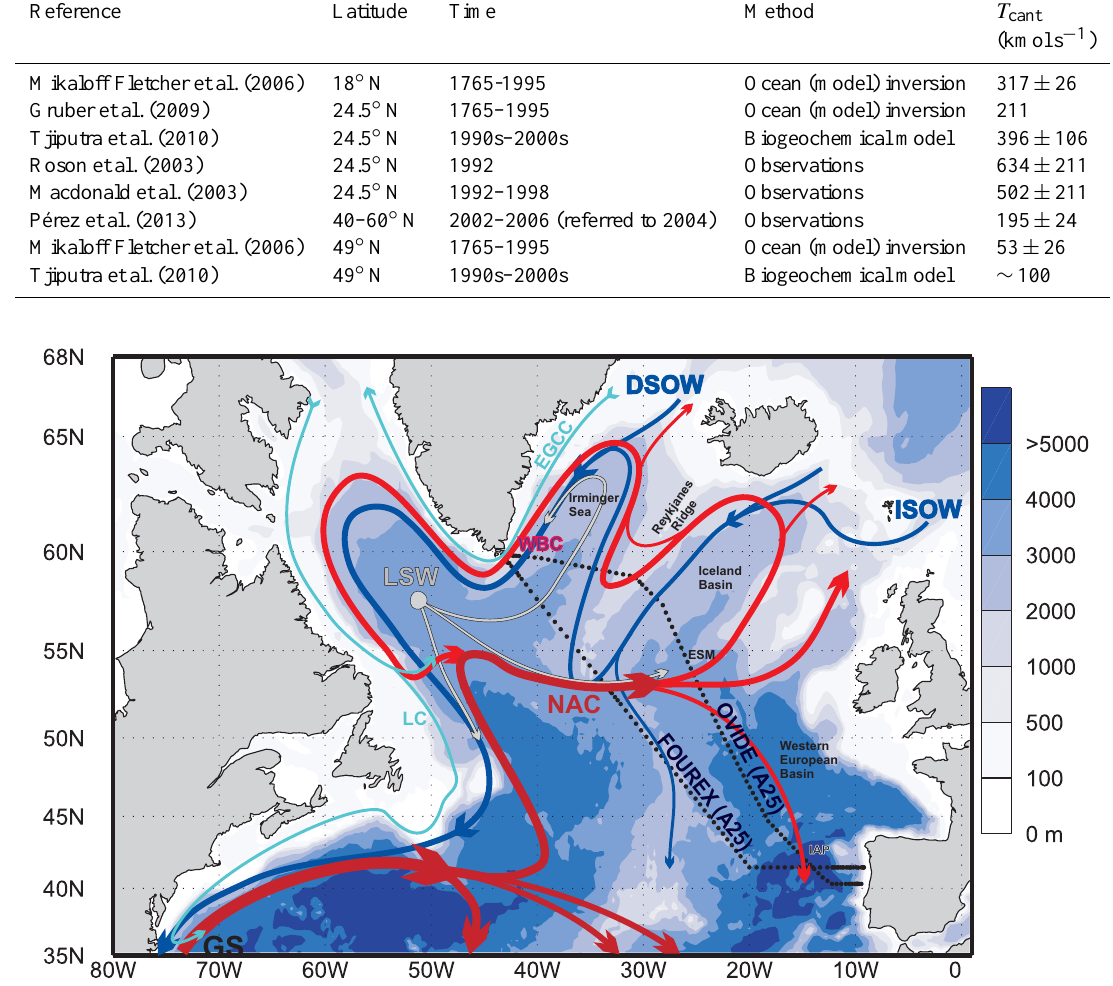
Fig. 1. Schematic circulation in the North Atlantic. The main pathways of warm and salty waters originating from the subtropical Atlantic Ocean are shown in red lines while the deep currents are displayed in dark blue. The cyan lines represent the fresh and cold currents over the shelves (Eastern Greenland Coastal Current (EGCC) and Labrador Current (LC)). The grey lines indicate the spreading of the Labrador Sea Water (LSW). OVIDE and FOUREX sections are represented with dotted lines. The background displays the bathymetry. The other abbreviations are DSOW=Denmark Strait Overflow Water, ISOW=Iceland Scotland Overflow Water, WBC=Western Boundary Current, NAC=North Atlantic Current, GS=Gulf Stream, ESM=Eriador Seamount, and IAP=Iberian Abyssal